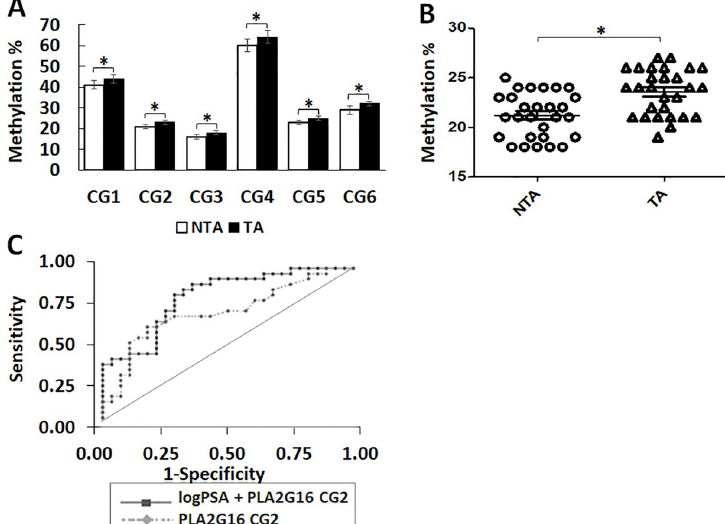
Fig 3. Methylation of PLA2G16 increases in histologically normal biopsies from patients with PC. A: PLA2G16 methylation for all detected CG loci in prostate biopsies. The values are from 3 individual experiments, shown as percentage Mean ± SEM. All loci shown were significantly altered in TA (n = 28) when compared to NTA (n = 28) samples, student’s t-test, � p < 0.05. B: PLA2G16 methylation for each individual samples at CG2 is shown, Mean ± SEM p = 0.0075 C: ROC curves were generated for a predictive accuracy of univariate and multivariate binary logistic regression models for discriminating TA and NTA prostate biopsies. When used alone, PLA2G16 CG2 (dashed curve) discriminated between patients with and without known cancer (AUC 0.703, p = 0.01). A multivariate model incorporating logPSA and CG2 (solid curve) had higher a predictive accuracy (AUC 0.773, p = 0.0007) for discriminating TA vs NTA.